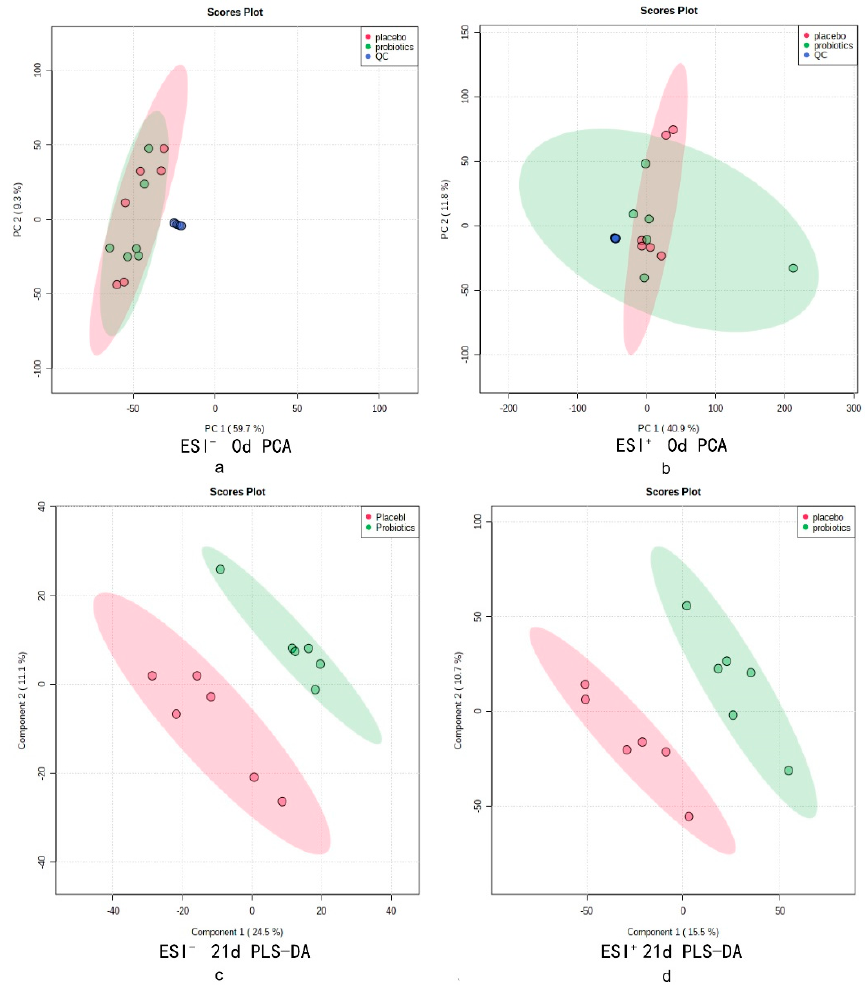
Figure 5. ( a,b ) The PCA analysis of QC and metabolic samples in negative and positive ion modes at 0-day; ( c,d ) The PLS- DA analysis of metabolic samples in negative and positive ion modes at